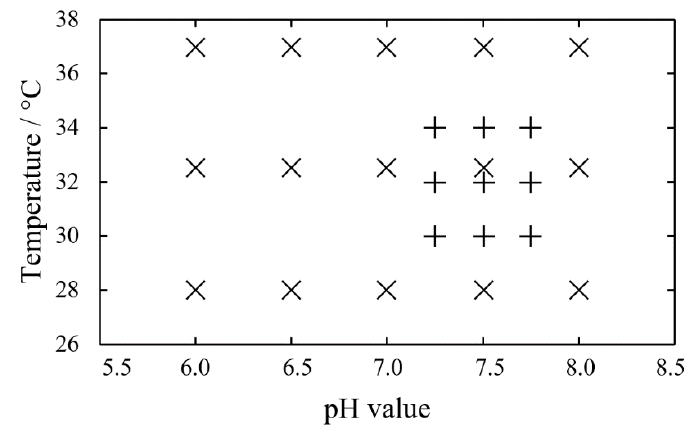
Figure 3. Experimental design chosen for the two circuit of design of experiments (DoE) (1st circuit: x; 2nd circuit: +).